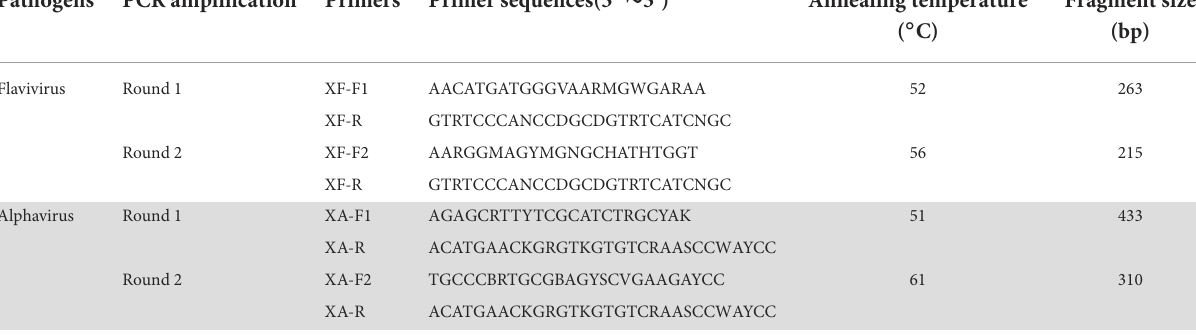
TABLE 1 Primers for testing flavivirus and alphavirus in mosquitoes using reverse transcription-hemi-nested polymerase chain reaction